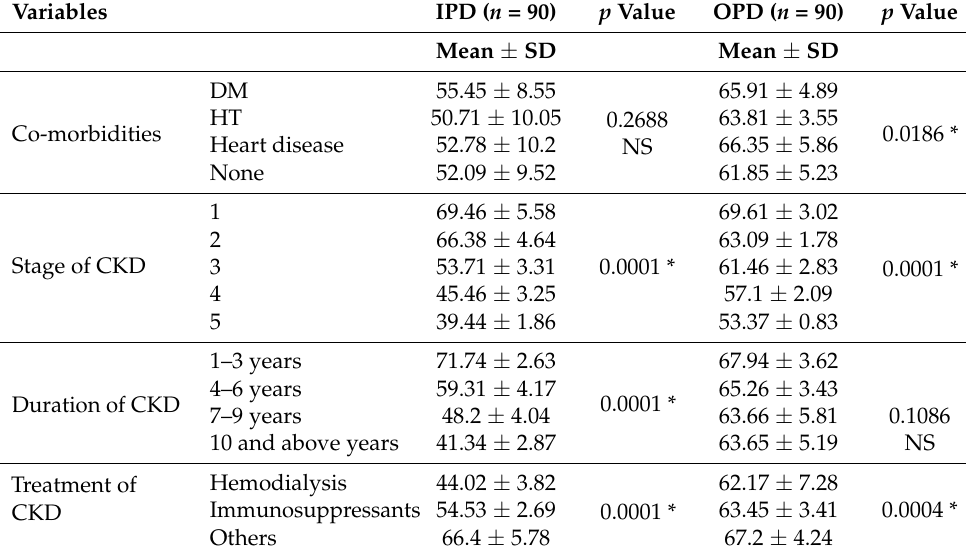
Table 6. Association of clinical variables with KDQOL-SF summary scores of the